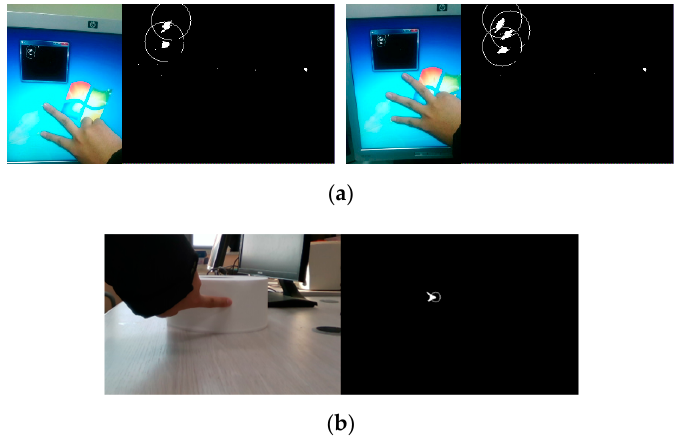
Figure 9. Touch point detection: ( a ) for flat surface; ( b ) for curved surface.